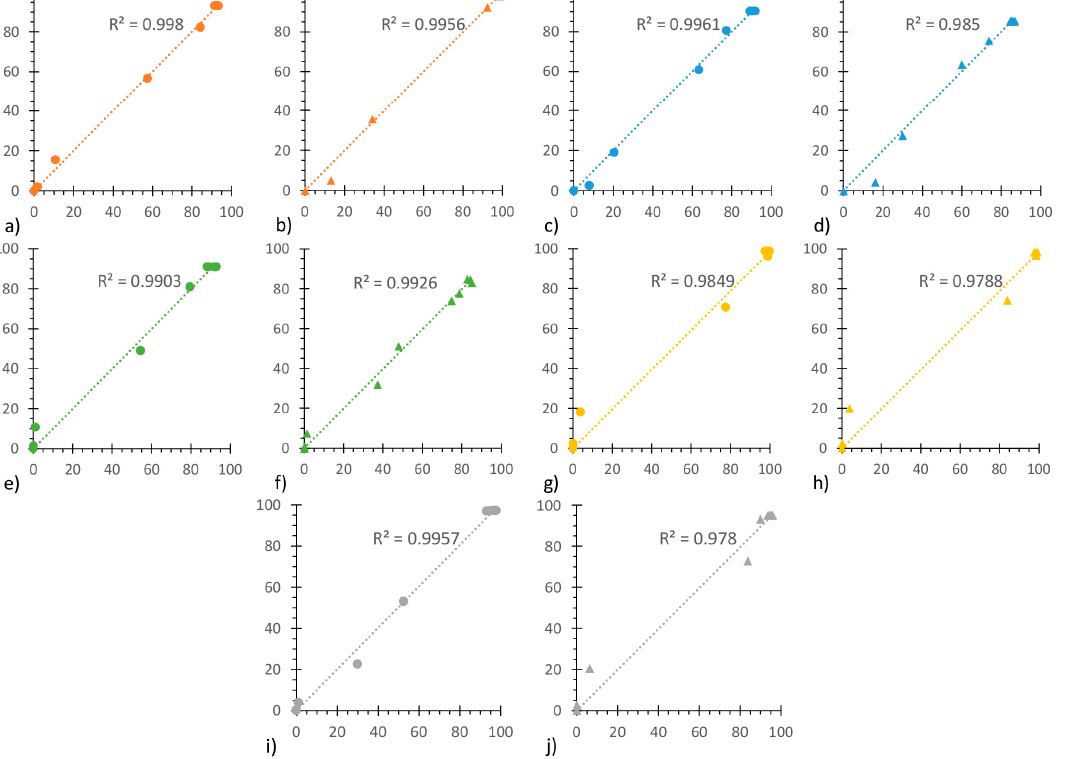
Figure 4. Correlation plots between experimental X ( t ) ( x -axis) and analytical X ( t ) ( y -axis): ( a ) A1T specimen; ( b ) A1U specimen; ( c ) A2T specimen; ( d ) A2U specimen; ( e ) C1T specimen; ( f ) C1U specimen; ( g ) C2T specimen; ( h ) C2U specimen; ( i ) C3T specimen; ( j ) C3U specimen. Dot lines are the bisectors.